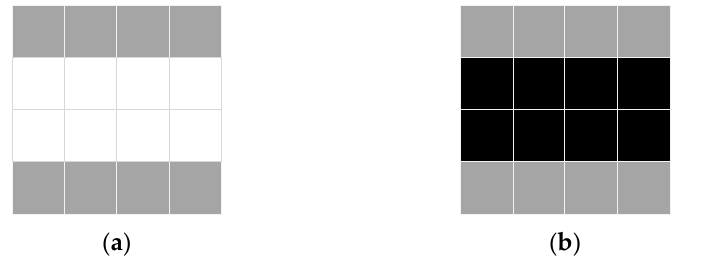
Figure 6. The embedded template of the watermark: ( a ) Watermark bit “1”; ( b ) Watermark bit